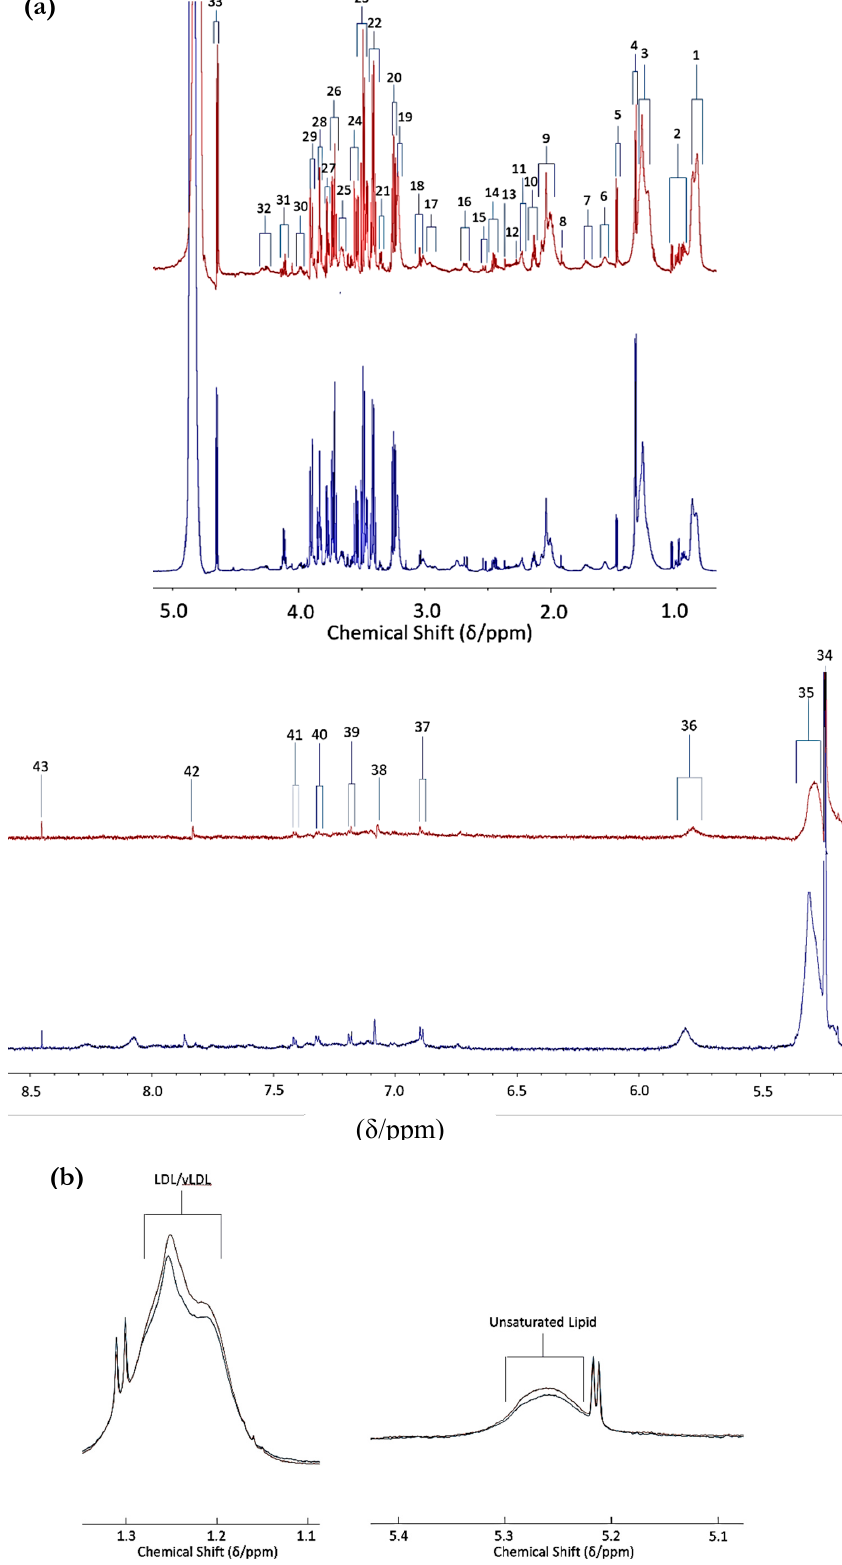
Figure 2. GM1 Type II and control plasma NMR profiles. ( a ) Typical 700 MHz 1 H NMR spectral profiles from GM1 Type II gangliosidosis and corresponding control plasma (blue and red spectra respectively). Assignments: [1] very-low-density-lipoprotein (vLDL) / low-density-lipoprotein (LDL)